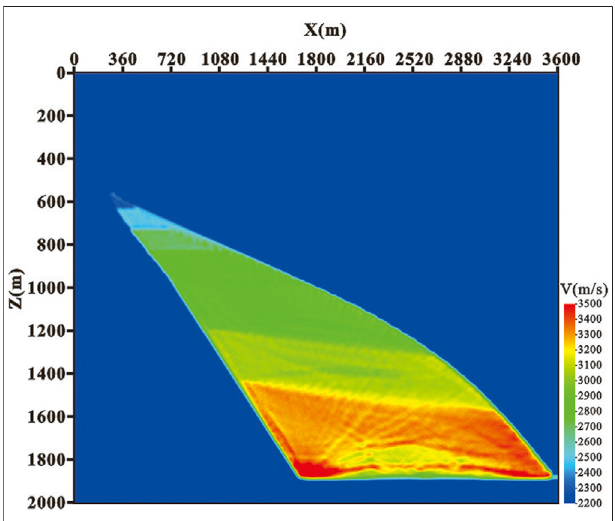
FIGURE 11 | Result of fi rst-arrival wave velocity